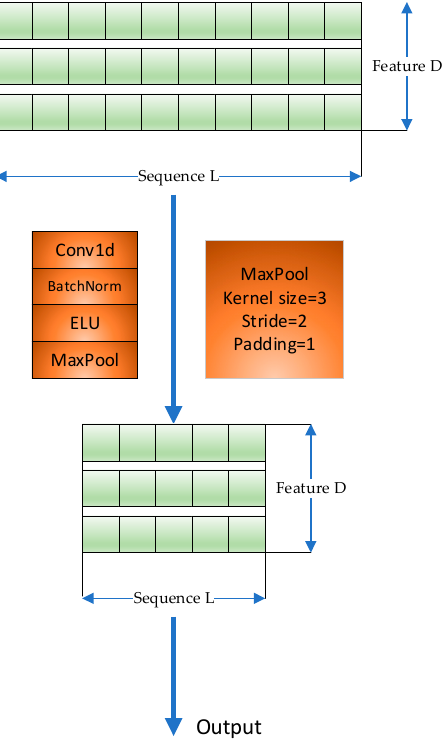
Figure 5. Illustration of the distilling layer.